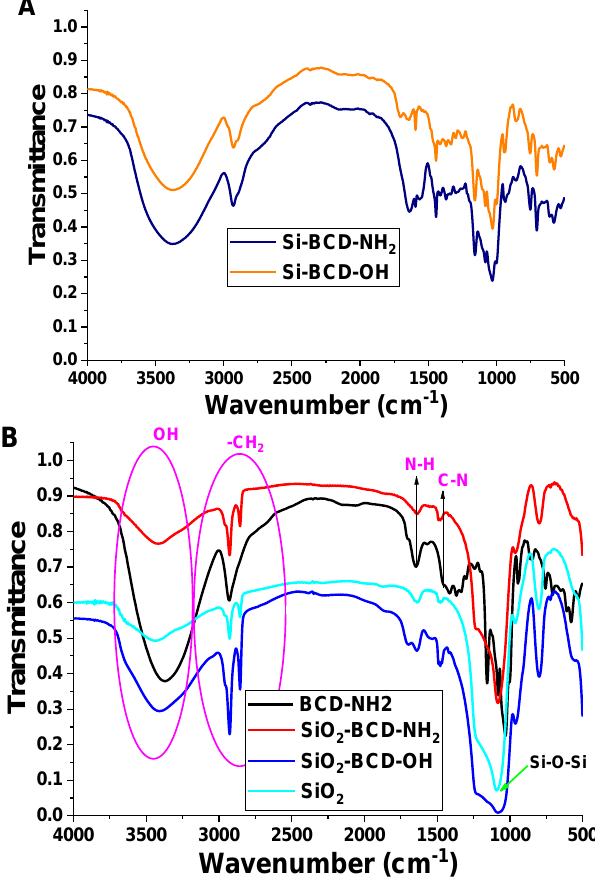
Figure 1. FT-IR spectra of the BCD silane derivative (Si-BCD-OH and Si-BCD-NH 2 ) ( A ) and of the BCD-modified silica ( SiO 2 -BCD-OH , SiO 2 -BCD-NH 2 , SiO 2 blank reference, and BCD-NH 2 ) ( B ). In the case of Si-BCD-OH, the characteristic bands of the hydroxyl and carbonyl groups can be noticed in the 3373 and 1726 cm −1 regions. The band observed at 2938 cm −1 specific bands for the urethane functional group 1736, 1608, 1570, and 1520 cm −1 were pre-